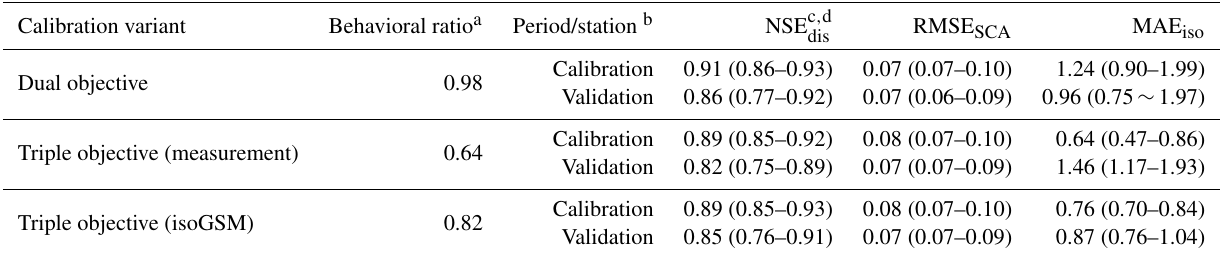
Figure 6. Uncertainty ranges of discharge (Nuxia station) and SCA simulations in the YTR basin during calibration and validation periods produced by the behavioral parameter sets of the dual-objective (a, b) , interpolation-forced triple-objective (c, d) and isoGSM-forced triple- objective (e, f) calibration variants. The discharge data are hidden due to the data security policy. Table 3. Comparisons of the model performance in the YTR basin produced by different calibration